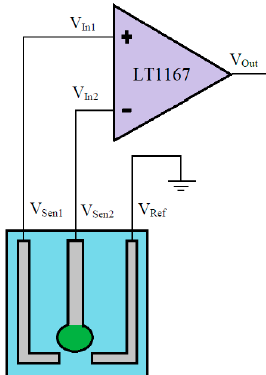
Figure 4. The schematic diagram of V-T measurement system with LT1167 instrumentation amplifier for the arrayed flexible RuO 2 /GO chloride sensor [30].